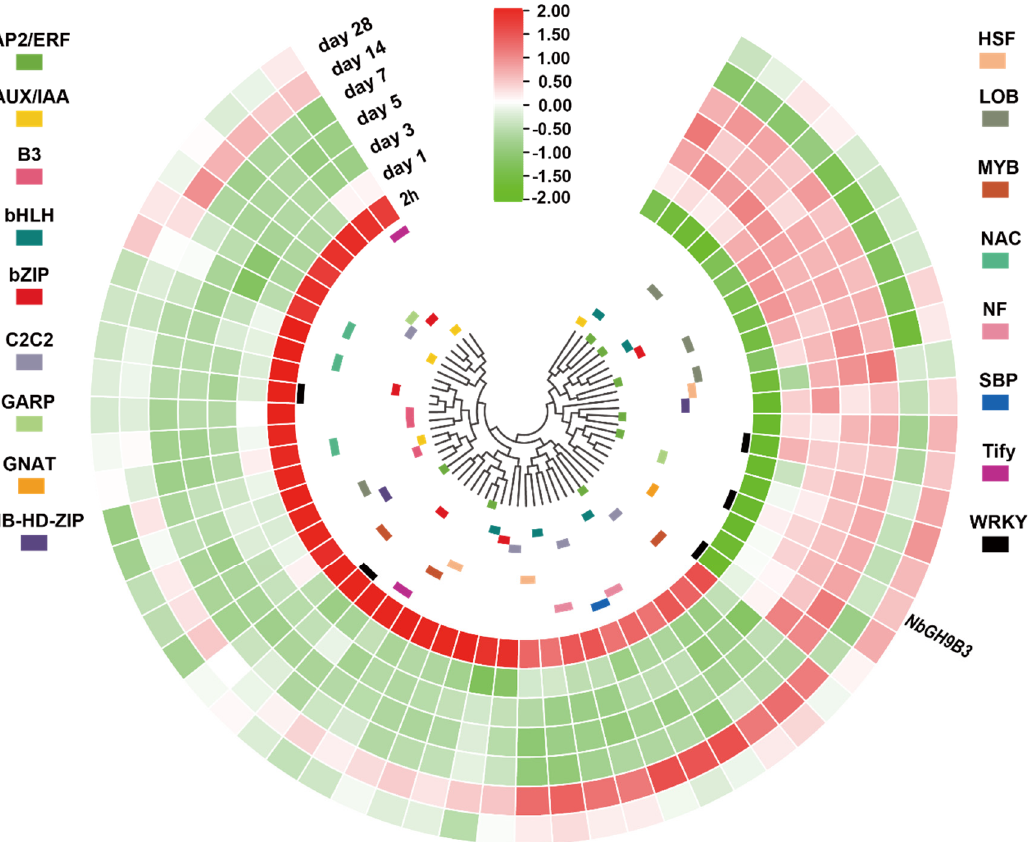
Figure 8. Co ‐ expressed transcription factor genes of NbGH9B3 in the weighted correlation network analysis (WGCNA) results. Tbtools was used to visualize the expression data. Log2, row scale and normalization was applied on the RNA ‐ seq based reads per kilo base per million mapped reads (RPKM) value. Circle heatmap shows the co ‐ expressed transcription factor genes of NbGH9B3 .